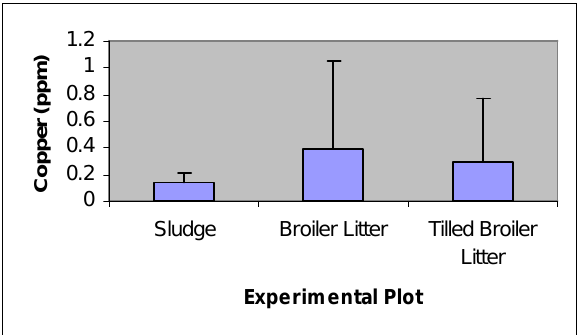
Figure 3 : Mean copper levels (ppm) detected in the various experimental plots.